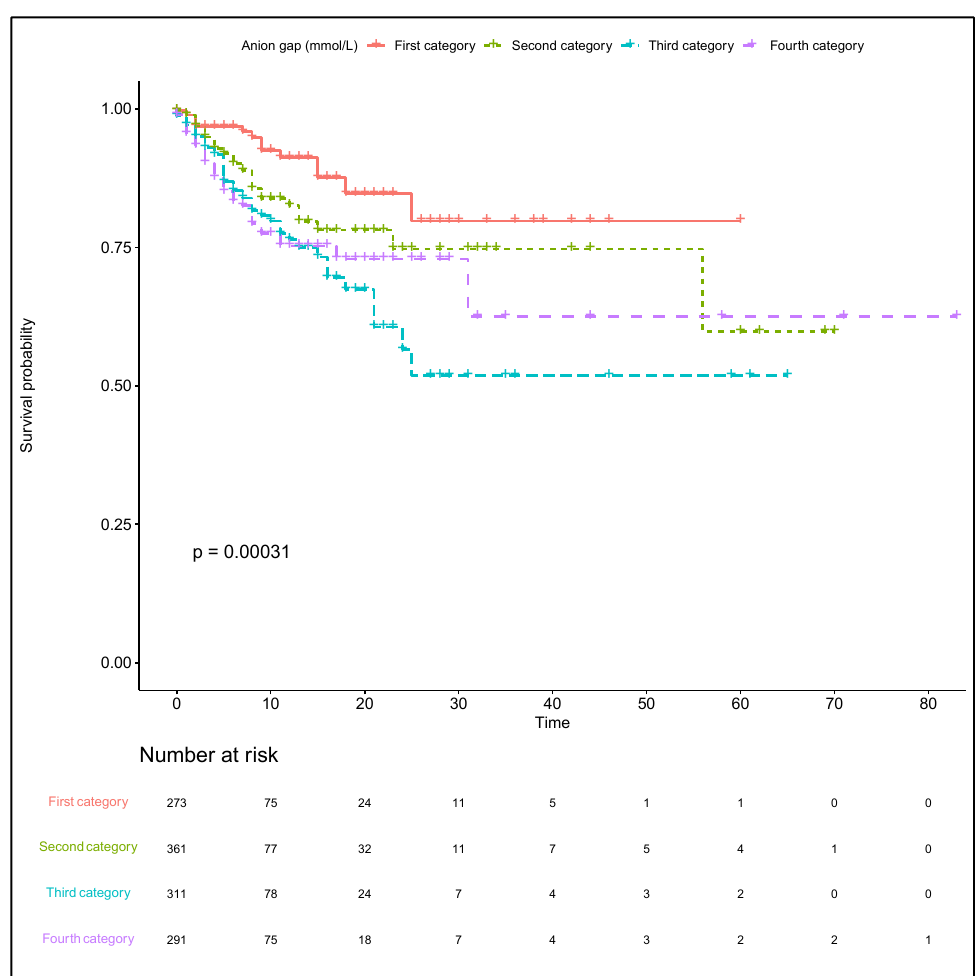
Figure 3. Kaplan–Meier curves indicating the association between the AG category and in-hospital mortality. Red line: first category. Green line: second category. Blue line: third category. Purple line: fourth category. AG: anion gap.